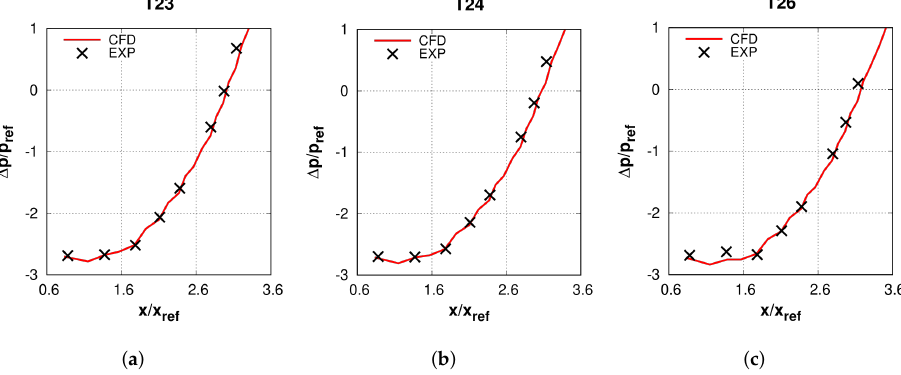
Figure 4. Compressor pressure at casing for the operating points experimentally tested: ( a ) T23 (MEL), ( b ) T24, ( c )